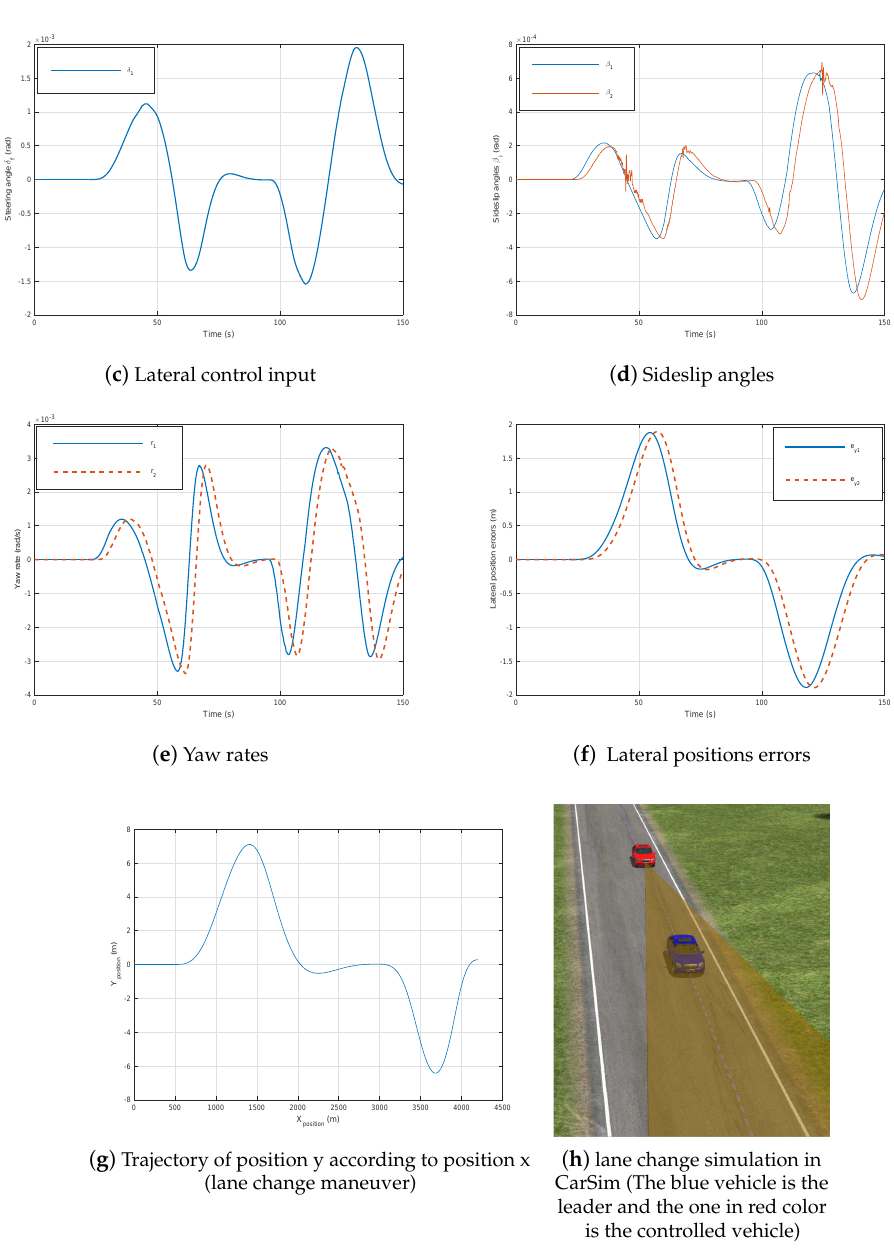
Figure 12. Two-vehicle platoon system under controllers (47) and (50) through the communication